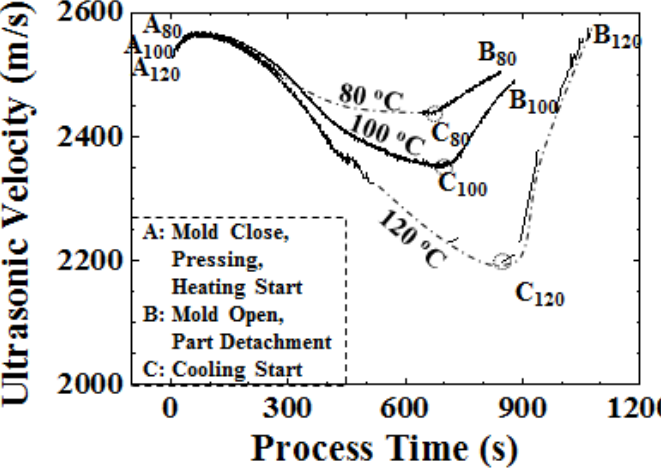
Figure 12. Variation of ultrasonic velocities under temperature settings of 80, 100 and 120 °C, indicating the mold closure, pressing, heating, cooling and mold opening during the hot embossing process. Higher temperature settings caused a lower ultrasonic velocity at the cooling starting point, as well as a longer processing period.